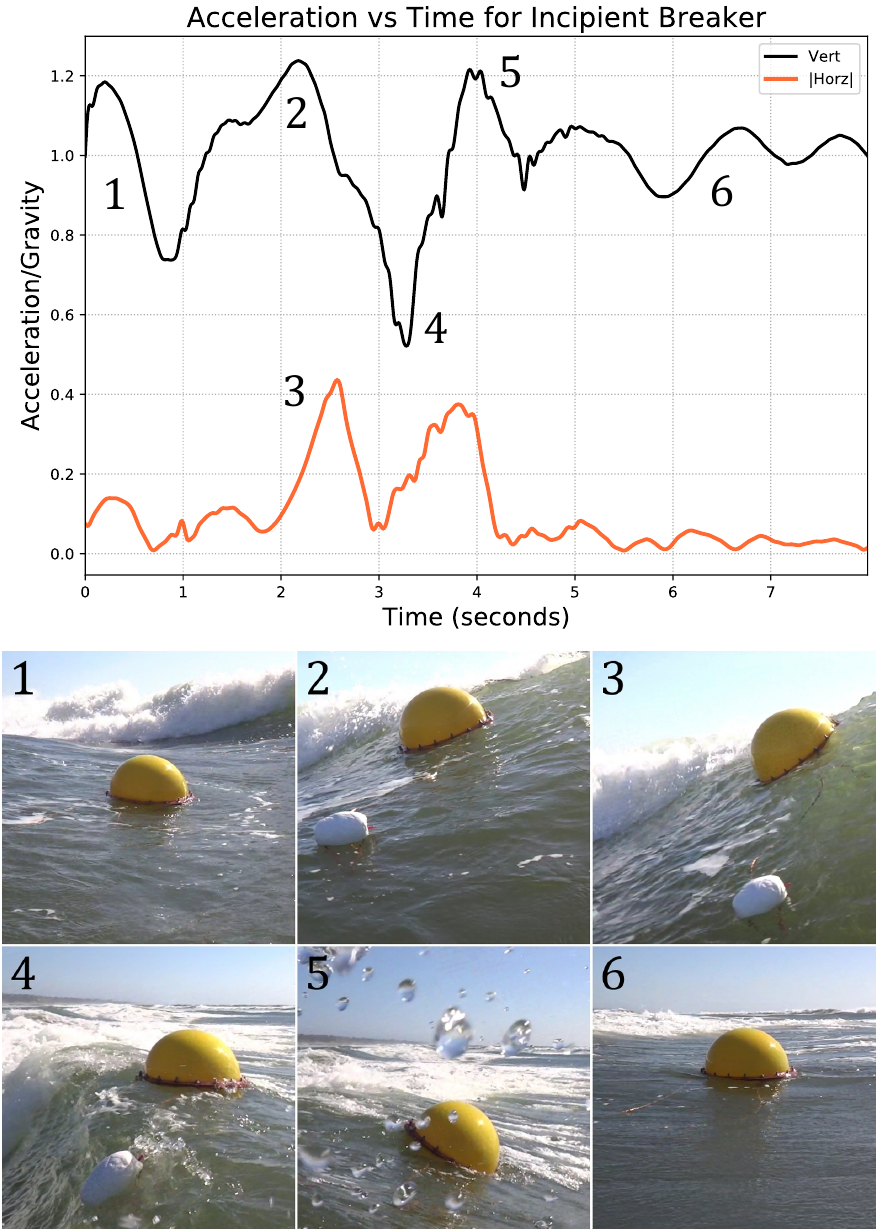
Figure 6. A sequence of screen captures from the video of an incipient wave encounter is shown below a plot of the induced buoy accelerations. The buoy is shown: (1) floating in the preceding wave trough, (2) rising up the front face of the wave, (3) just prior to cresting the wave, (4) passing over the wave crest, (5) diving into the rear face of the wave, and (6) regaining equilibrium after the wave has passed. Wave recorded on 10 April 2014 at 16:20:06